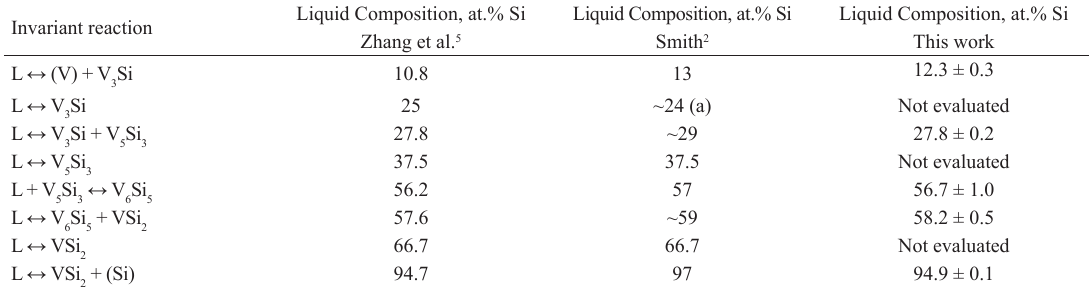
Table 4: Liquid compositions at invariant reactions in the V-Si system. Liquid Composition, at.% Si Liquid Composition, at.% Si Liquid Composition, at.% Si Invariant reaction Zhang et al. 5 Smith